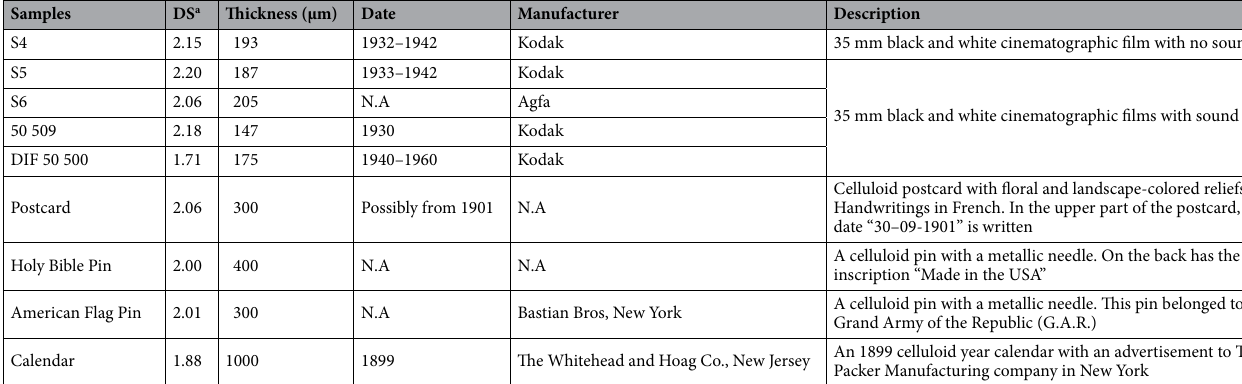
Table 1. Description and degree of substitution (DS) of the cinematographic films and celluloid objects studied (Perlov’s celluloid collection). a Degree of substitution calculated by µFTIR using the calibration curve described in Nunes et al. 33